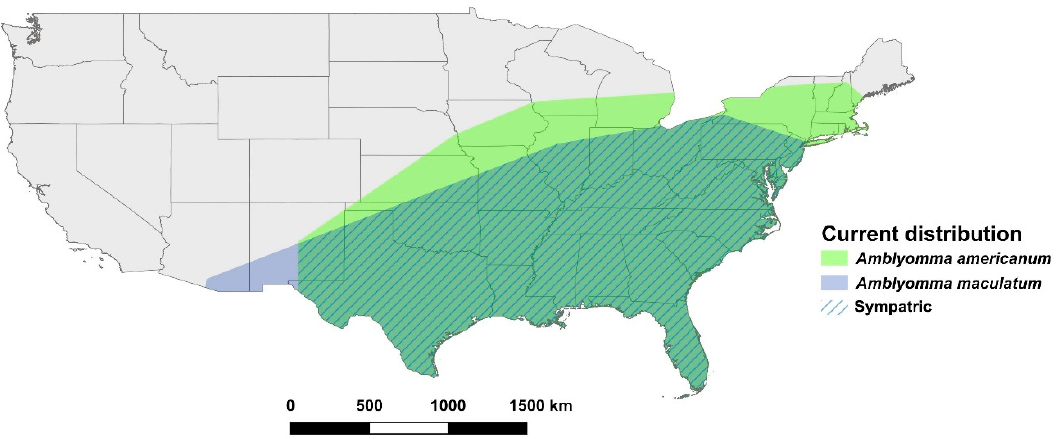
Figure 1. The current USA distributions of Amblyomma americanum (the lone star tick) and A. maculatum (the Gulf Coast tick) based on the generation of a convex polygon around geolocations for each species from the scientific literature and online databases collected for MaxEnt modeling (see Supplementary Materials for full list of geolocations).